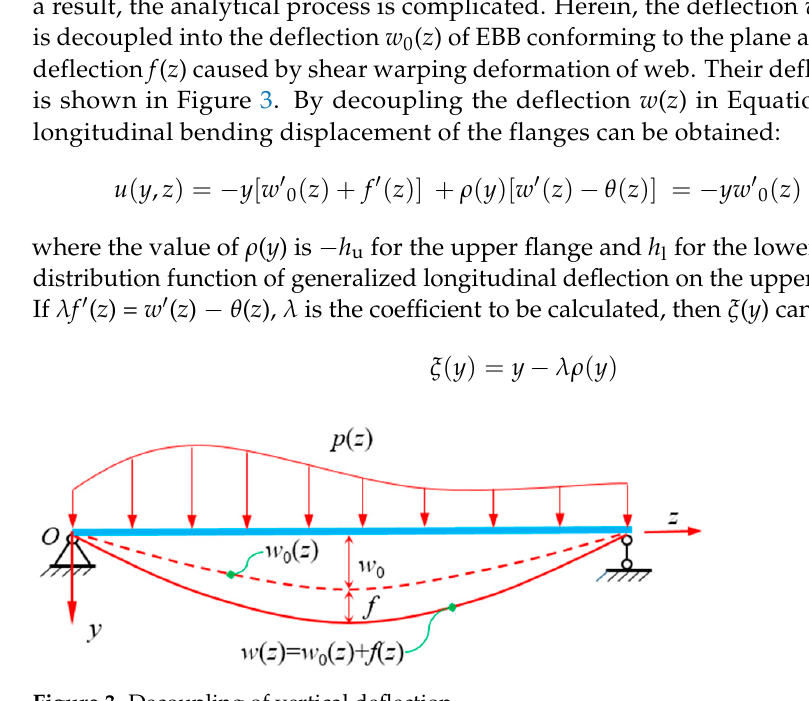
Figure 3. Decoupling of vertical deflection.